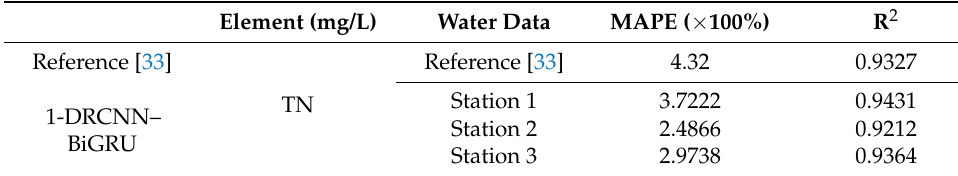
Table 5. Comparison of TN prediction